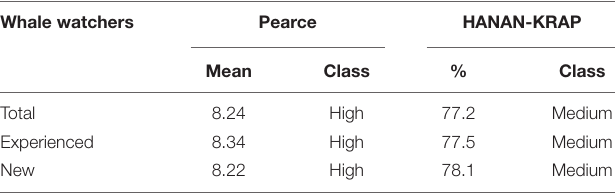
TABLE 3 | Overall satisfaction level of whale watchers and separately for the two groups. Whale watchers